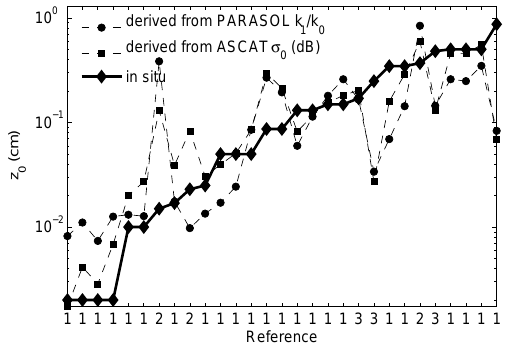
Fig. 4. Scatter plot of the modeled z 0 estimates using ASCAT and PARASOL, versus the sorted in situ z 0 values (see Table 1). Refer- ence 1 for Marticorena et al. (2004), 2 for Greeley et al. (1997), and 3 for Marticorena et al.